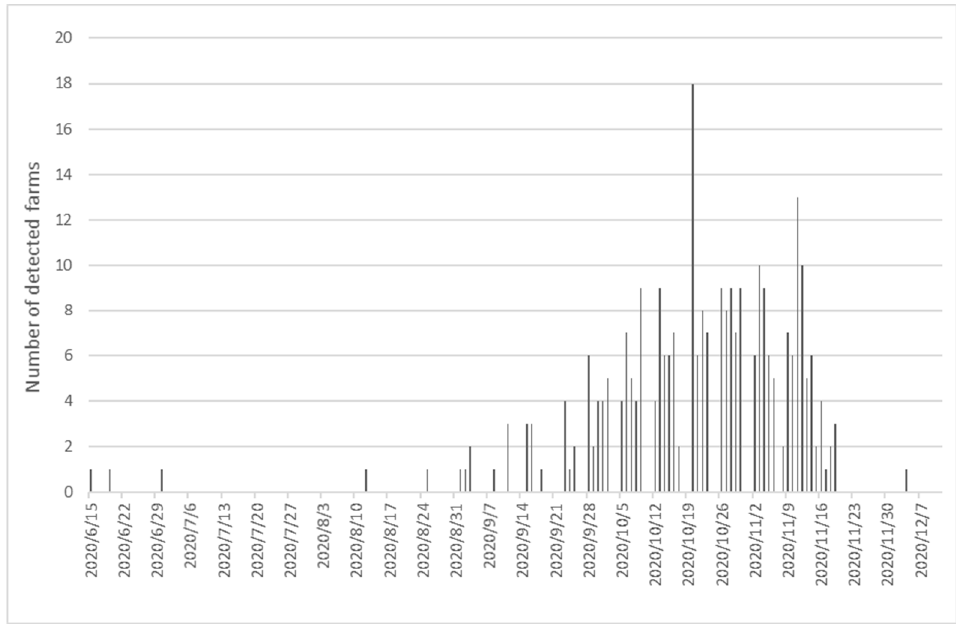
Figure 1. Number of Danish mink farms tested positive for SARS-CoV-2 per day in the